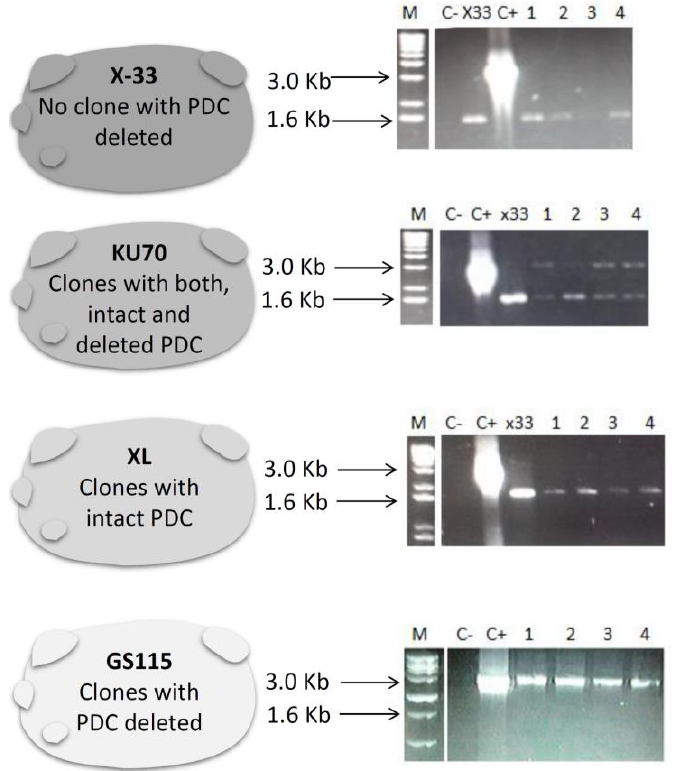
Figure 2. The four P. pastoris strains used for the insertion of the PDC knockout cassette with their respective results among all screened clones. The PCR results using the primers PDC5’F and PDC3’R are shown after electrophoresis on a 0.8% agarose gel. Kb: kilobases; M: molecular marker; C−: negative control (no DNA template in the PCR reaction); C+: positive control (Plasmid pUG6-PDCK as template in the PCR reaction), X-33- Pichia pastoris wildtype strain where PDC is not deleted. Numbers 1–4 are samples of different clones that were evaluated for deletion of PDC .